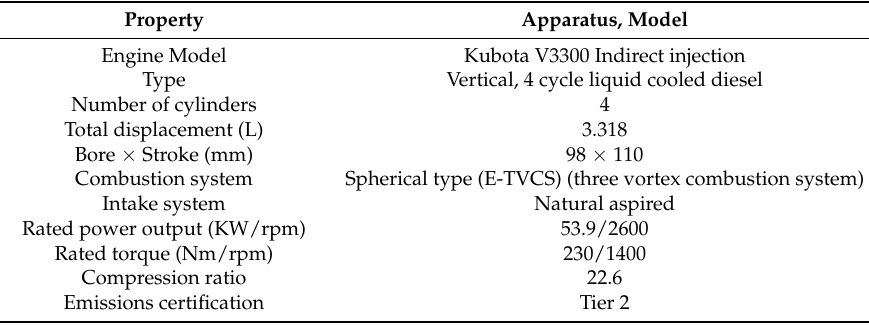
Table 5. Details of the test